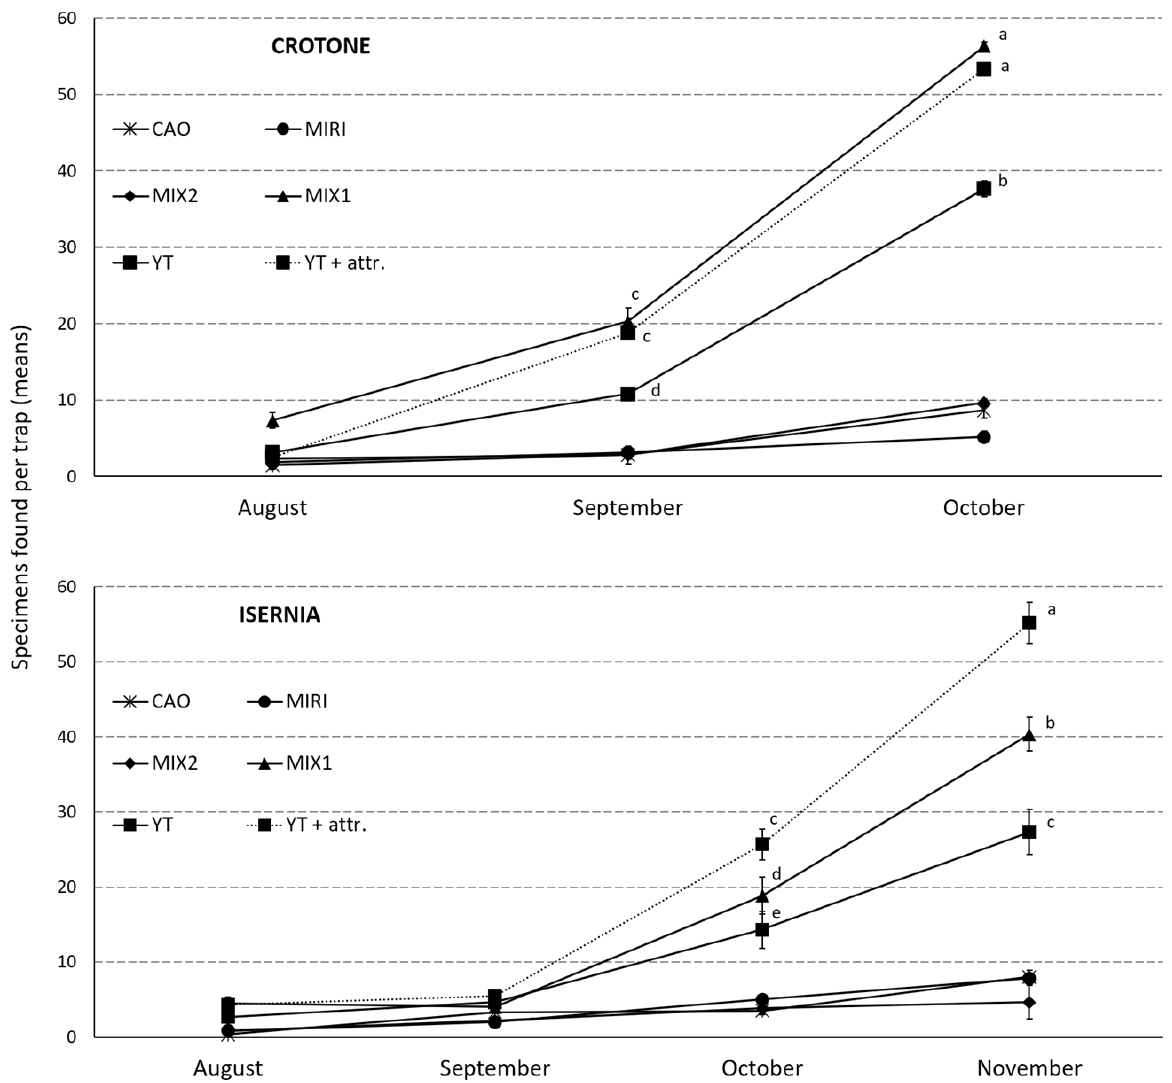
Figure 5. Catches (average ± standard deviation) of adult OLF recorded in Crotone (upper graph) and Isernia (lower graph) during 2019–2020. CAO = Kaolin clay sprayed on the crowns; MIRI = Isopropyl-Myristate, 15 mL per dispenser; MIX2 = Mixture in equal parts of the SWs obtained from cellulose, wood, corn and alfalfa at both 300 and 500 ◦ C, 15 mL per dispenser; MIX1 = Mixture in equal parts of the SWs obtained from olive mill waste at both 300 and 500 ◦ C; 15 mL per dispenser; YT = control (Yellow trap); YT + attr. = control (Yellow trap), panel + food bait and pheromone. Different letters mean significance, one-way ANOVA test, Post-hoc Student–Newman–Keuls test.